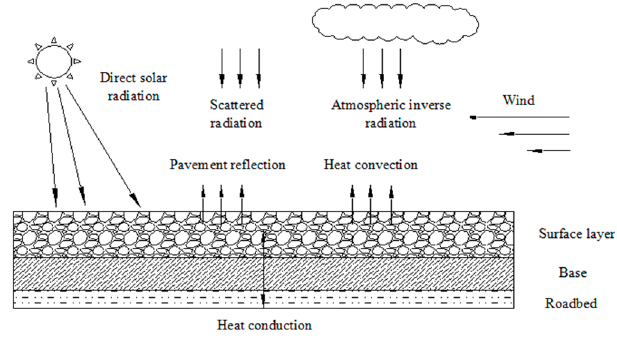
Figure 1. Thermal radiation characteristics of asphalt pavement.